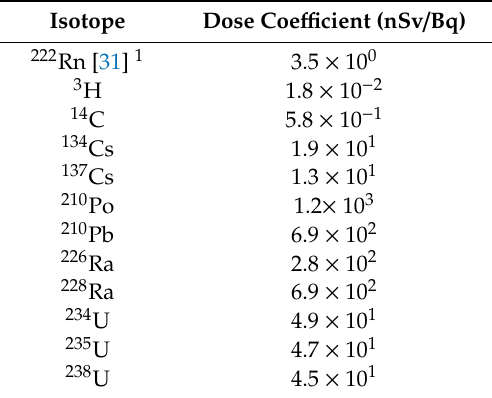
Table 2. Dose coe ffi cient values used for this study (nSv /